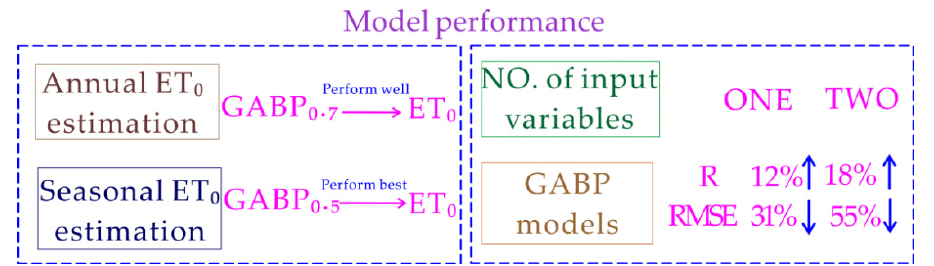
Figure 8. Graphic showing GABP model performance for ET 0 estimation compared with BP